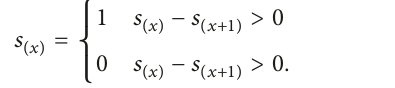
Figure 2 reflects the nine pixels. The upper left corner pixels act as the starting point. Each pixel value is determined in clockwise order, that is, integration into a row: S9 S8 S7 S6 S5 S4 S3 S2